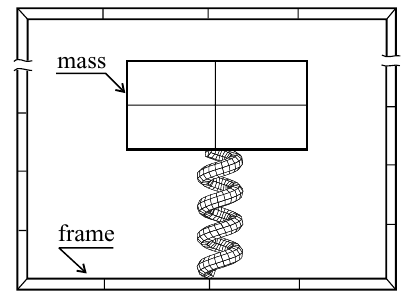
Fig. 3. FE mesh of the instrument casing with suspended mass.